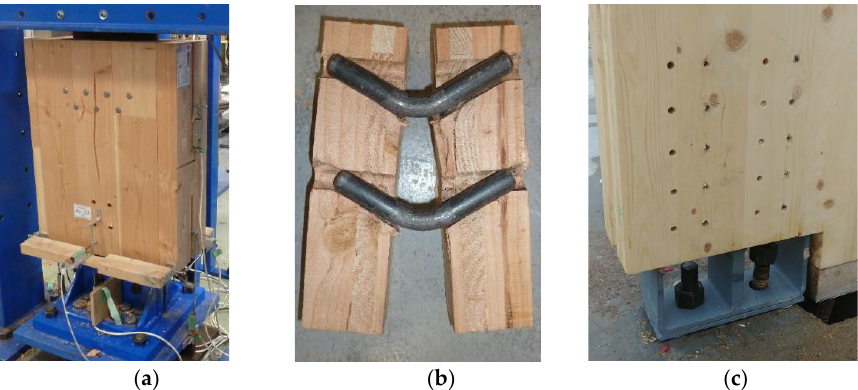
Figure 4. Dowelled slotted-in steel plates: ( a ) HD test setup; ( b ) ductile steel yielding and wood crushing failure modes (photo credit: ( a , b ) Justin Brown; ( c ) Fast + Epp, reprinted with permission).